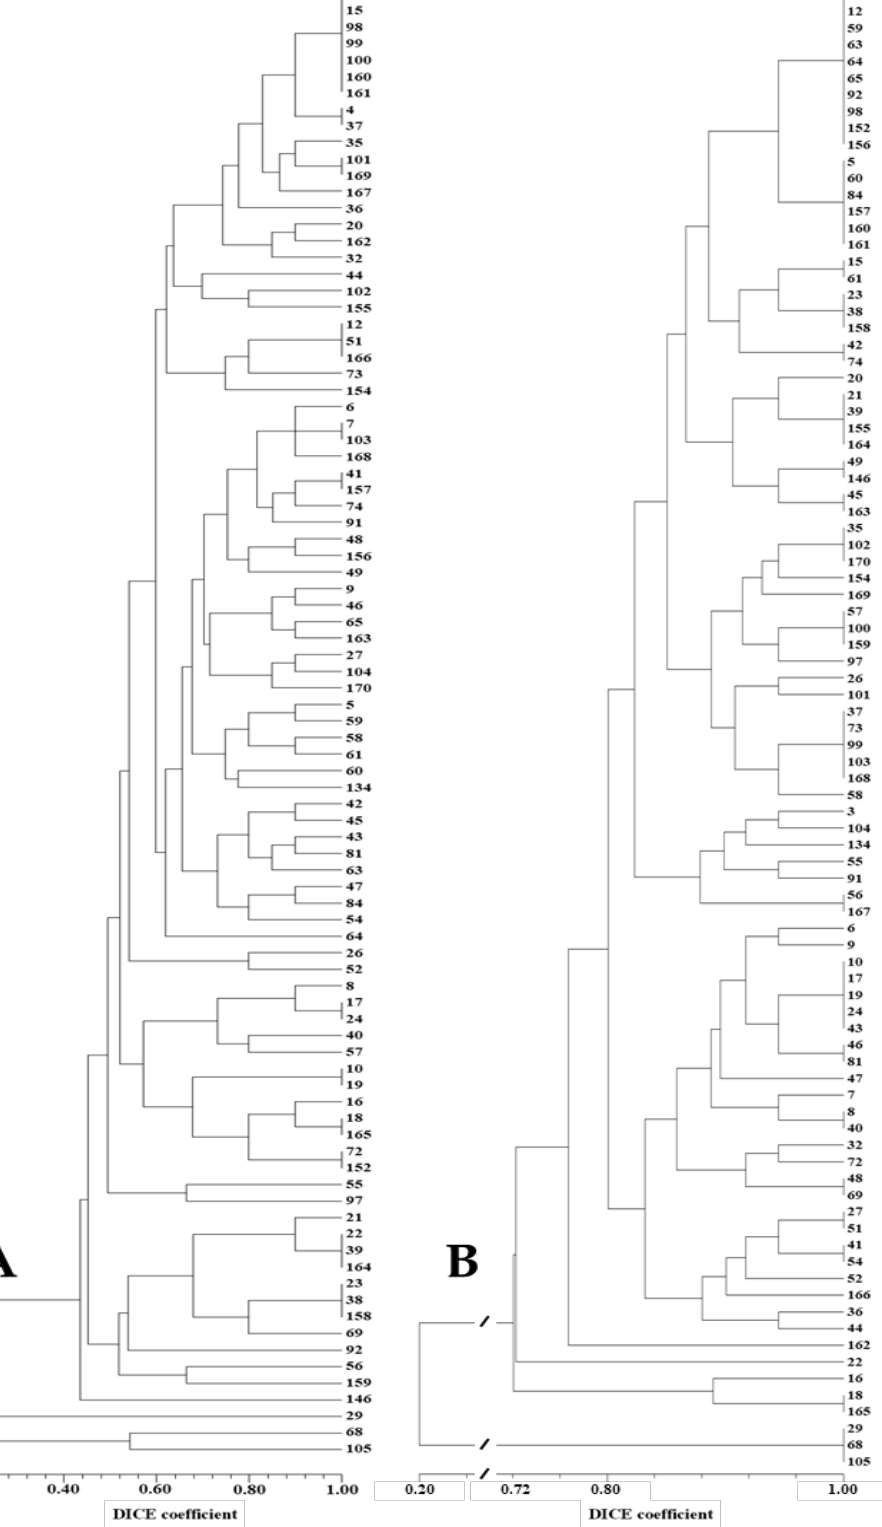
Figure 4. ( A ) Dendrogram depicting the genetic relationships among the 90 germplasm accessions established based on SSR markers. The E. sativa . accessions (Nos. 29, 68, and 105 at the bottom) are clustered apart from all other ( D. tenuifolia ) accessions. ( B ) Dendrogram displaying the genetic relationships among the 90 germplasm accessions established based on SNP-CAPS markers.